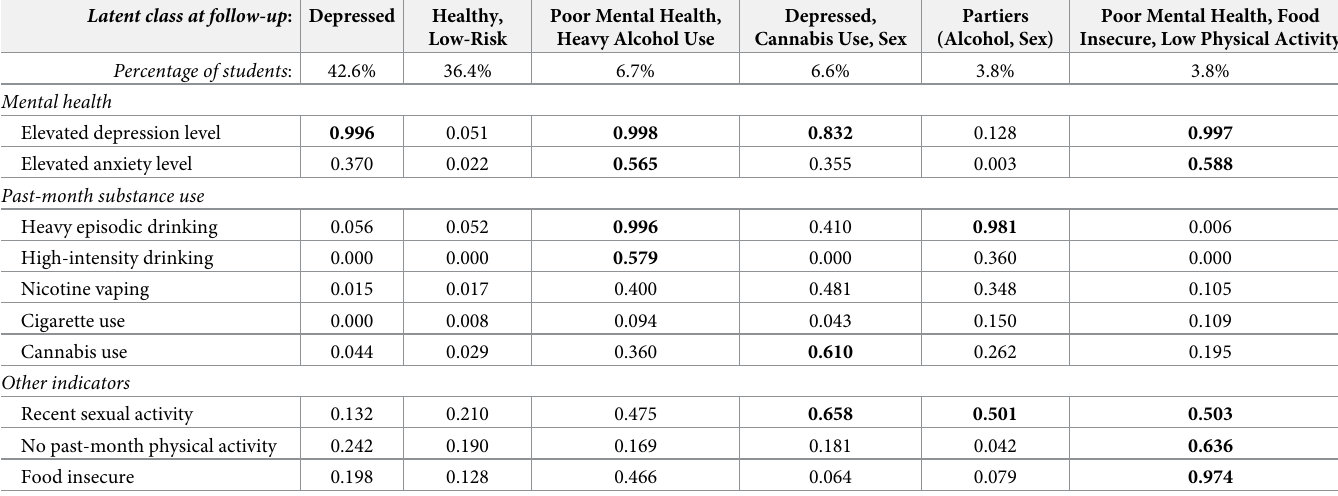
Table 4. Six-class model of college student health and well-being at